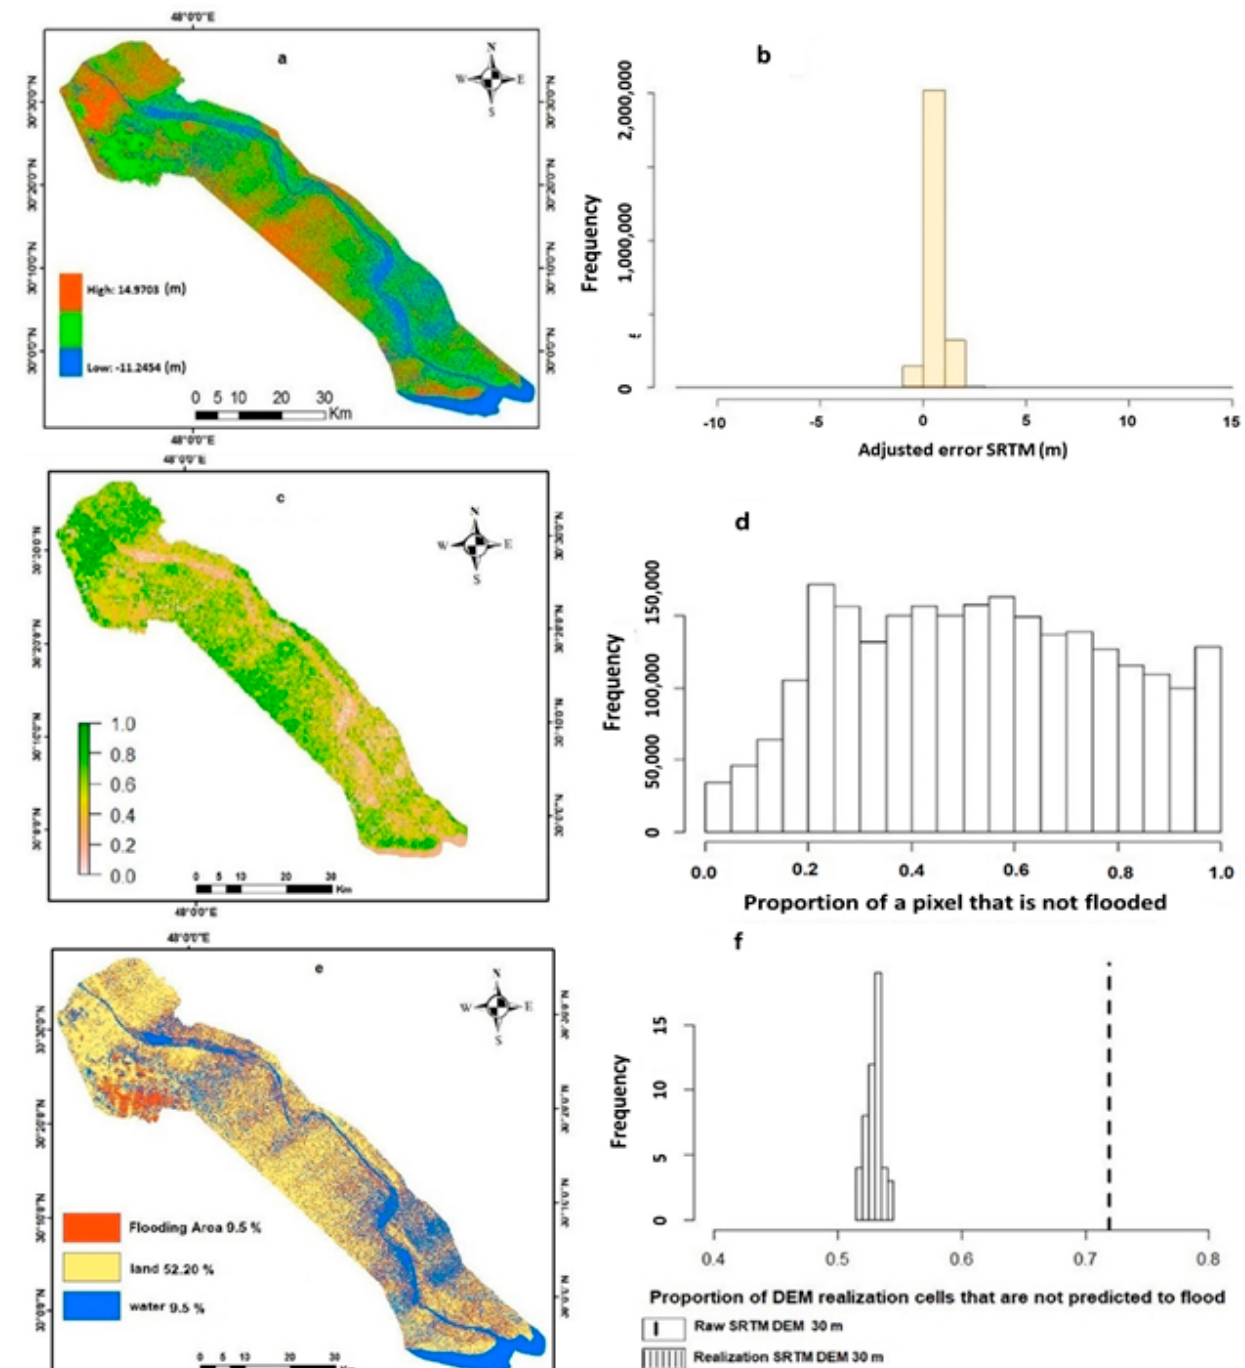
Figure 6. ( a ) SARR map of regression-adjusted SRTM elevation; ( b ) histograms of adjusted SRTM; ( c ) SARR probability map for land remaining dry following bathtub modelling of 1m inundation; ( d ) histogram of flooding probability; ( e ) SARR bathtub model using raw SRTM data; ( f ) proportion of SARR predicted to remain dry following 1m inundation: raw DEM is dashed line, histogram are areas across 50 realizations.